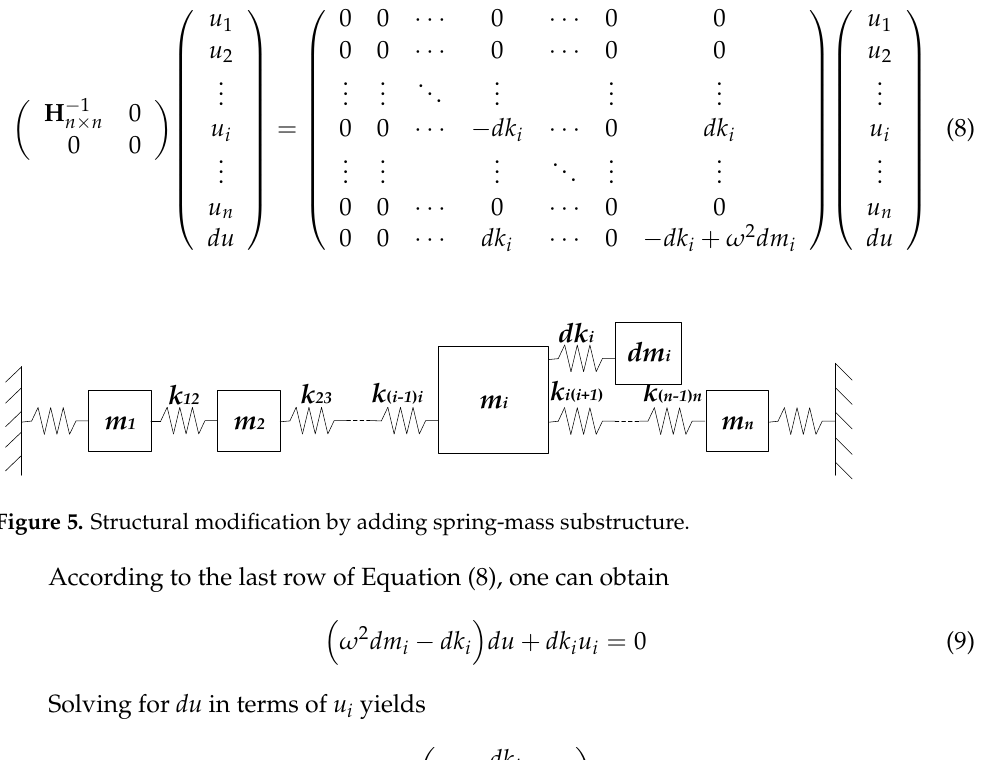
Figure 5. Structural modification by adding spring-mass substructure. According to the last row of Equation (8), one can obtain